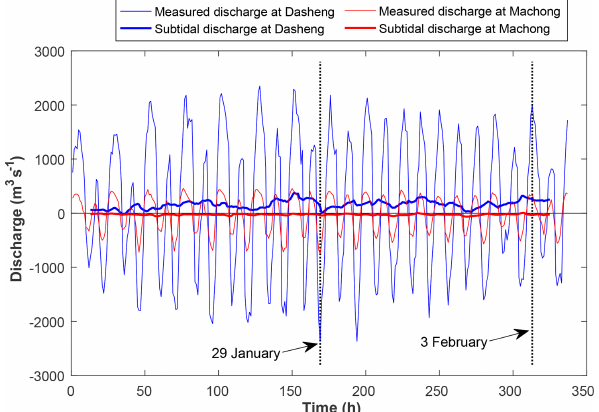
Figure 7. Subtidal discharge measured at Machong station and Dasheng station from 29 January to 3 February. Positive values in- dicate discharge in the seaward direction. Figure 8. Comparison between observed and computed salinity concentration over time on 31 January (neap tide) at study sites along the Humen